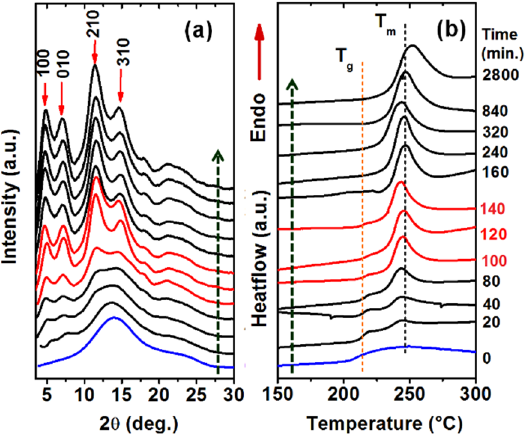
Figure 6. NC α form films, as obtained by sorption/desorption of BE in an amorphous 100 µ m PPO film for different sorption times: ( a ) radial profiles of 2D-WAXD THROUGH patterns; ( b ) DSC scans at h.r. = 10 °C/min. Table 1. BE guest sorption at room temperature in amorphous PPO films, with thickness of ~100 µ m, followed by guest removal leading to NC α form: sorption time (min); BE guest uptake (A t /A t ∞ ); WAXD crystallinity index (%); melting enthalpy (J/g); film thickness ( µ